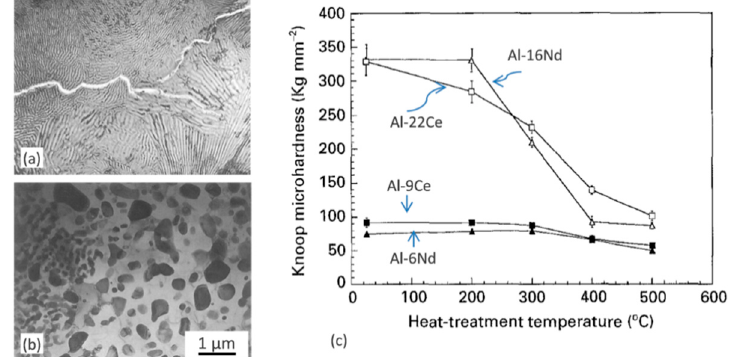
Figure 26. Thermal stability of rapidly solidified Al − Ce and Al − Nd alloys: ( a ) Al − 22Ce as spun cast; ( b ) Al − 22Ce after 2 h at 500 °C, TEM images; ( c ) microhardness after heating at temperatures from 200 to 500 °C for 2 h (alloy compositions are in wt.%) [125].